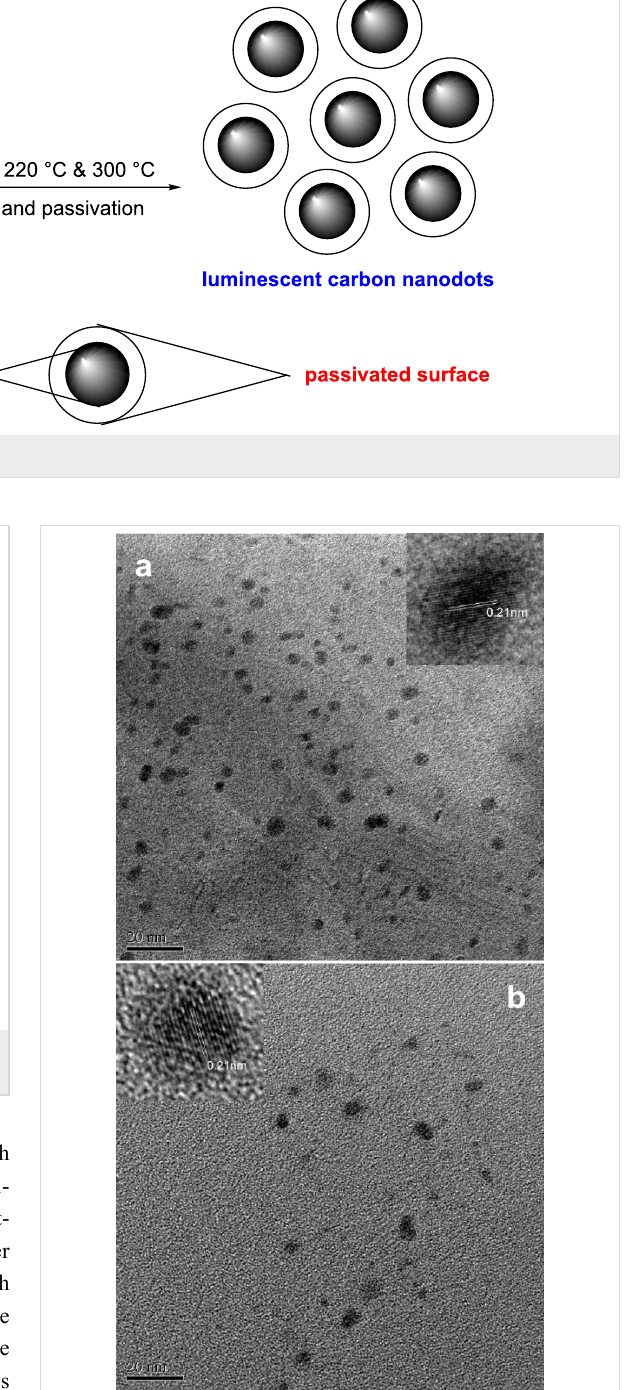
Figure 2: Recorded TEM images of tyrosine-passivated CNDs synthe- sized at two different temperatures (a) at 220 °C (b) at 300 °C, respect- ively.